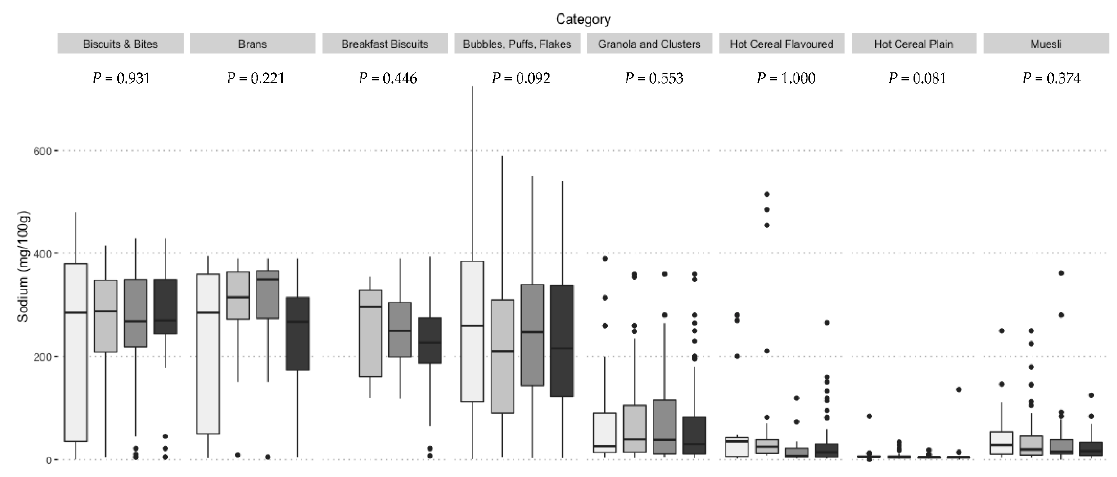
Figure A3. Sugars content of breakfast cereals (g/100 g) between 2013, 2015, 2018, and 2020; p value comparing 2013 vs. 2020 (2015 vs. 2020 for breakfast biscuits). * Statistically significant p < 0.05.